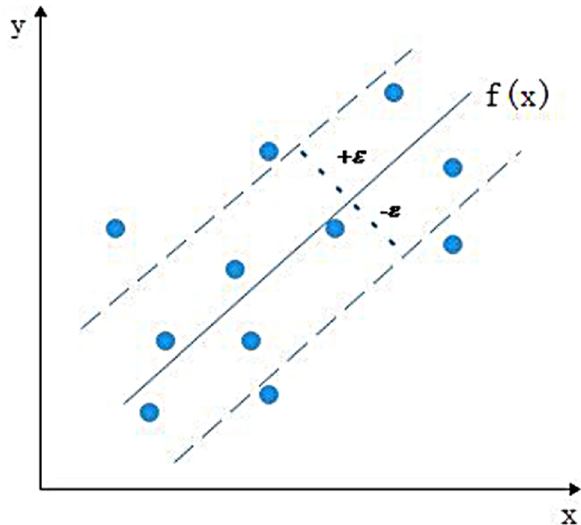
ε -insensitive band for the support vector machine